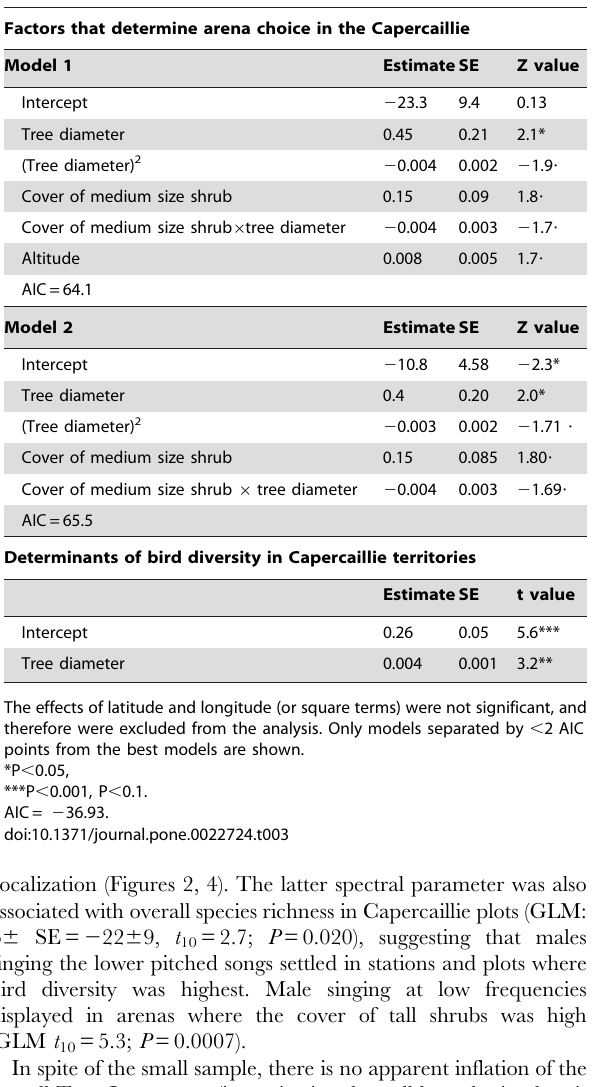
Table 3. Habitat determinants of Capercaillie choice of arenas, and of bird diversity in Capercaillie territories, as highlighted by GLMMs.